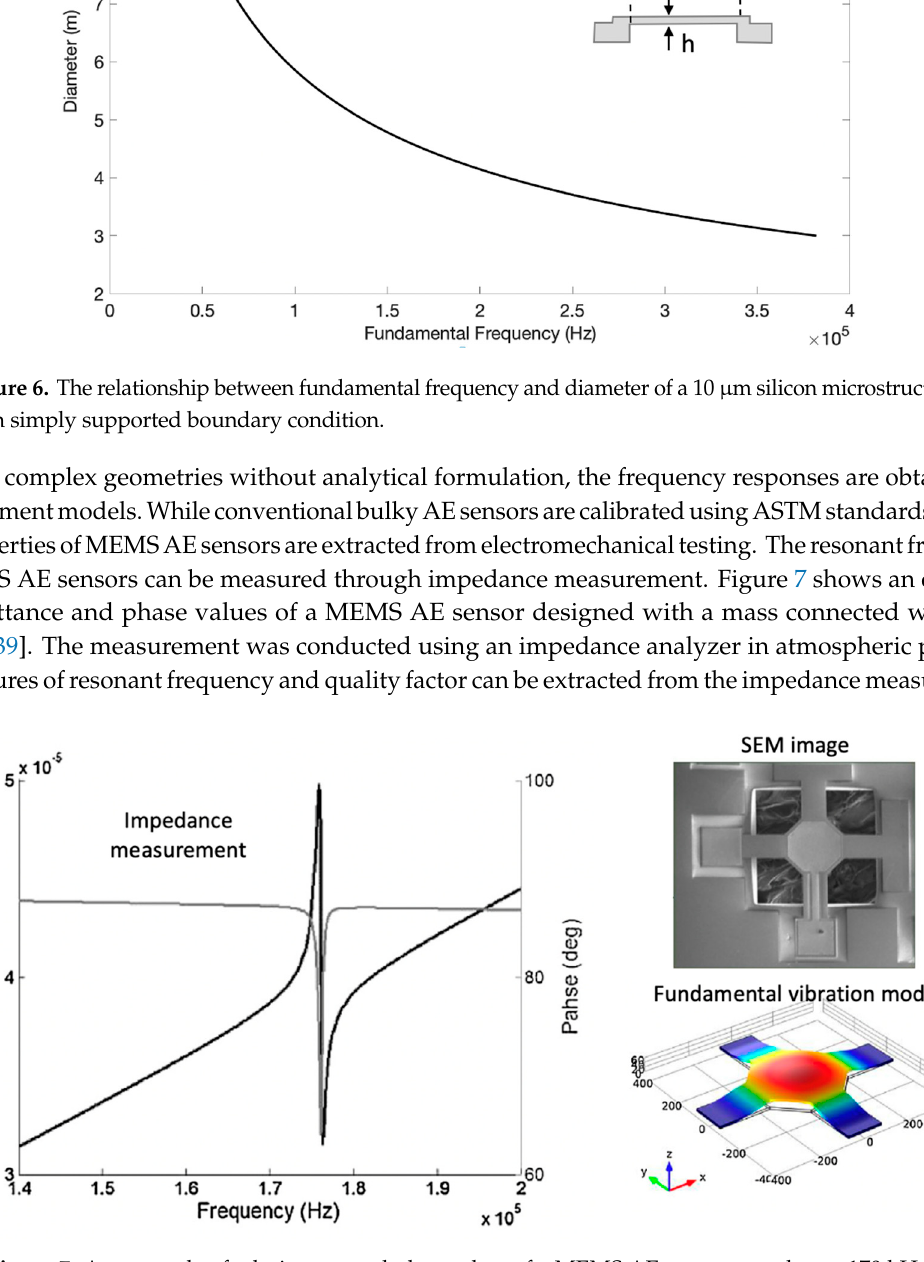
Table 2. Piezoresistive MEMS AE sensors and their specifications. Design Geometry